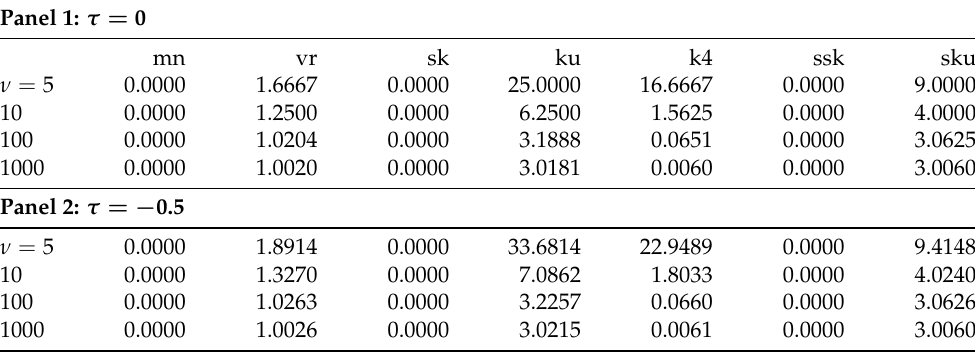
Table 6. Extended skew-Student moments, λ = 0 , τ ≤ 0